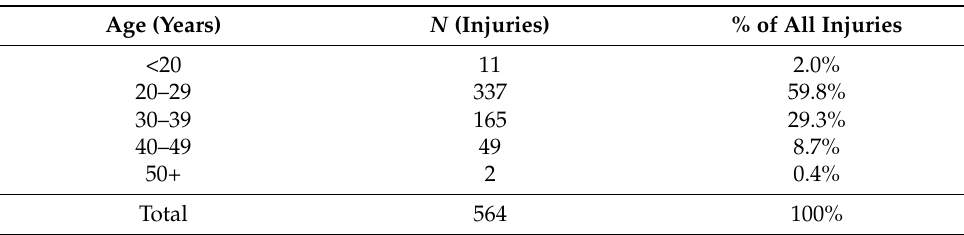
Table 2. Ages of trainees with reported injuries.